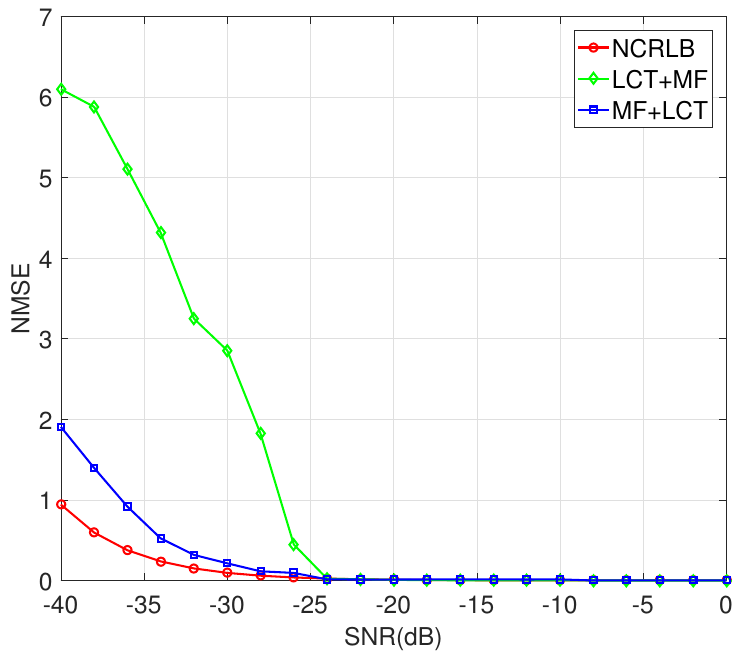
Figure 16. Speed estimation performance with different